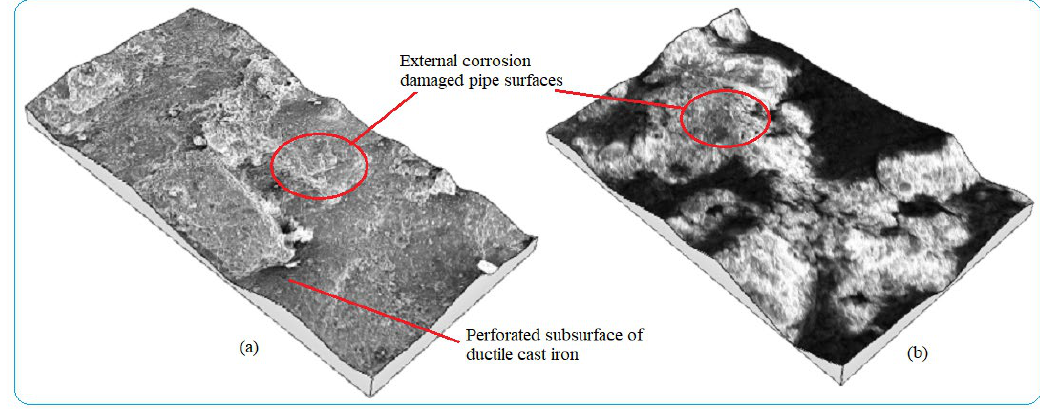
Figure 4. 3D images of external corrosion damaged pipe surface: ( a ) Ductile iron pipe and ( b ) Galvanized steel.